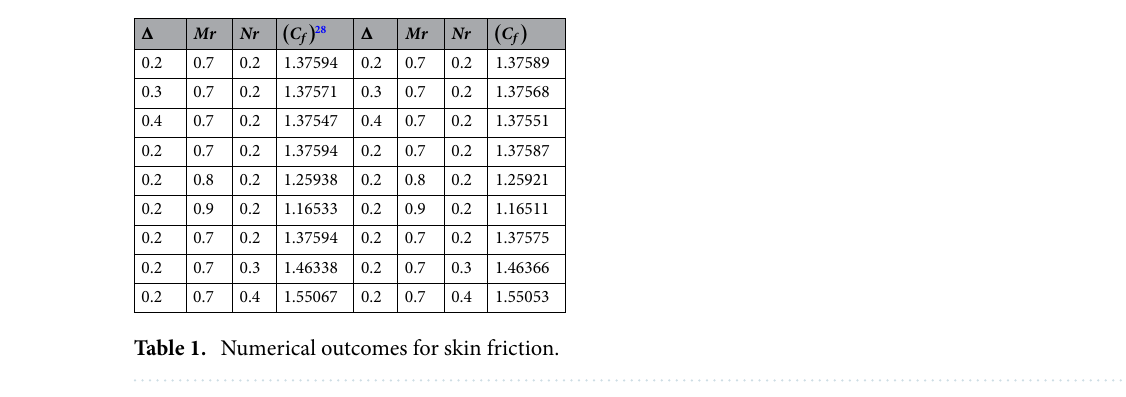
Figure 5. ( a – d ) The effects of parameters Sc , Sr and Du on dimensional less concentration profile φ(η) respectively. ( d ) Comparison of solution obtained by PCM and bvp4c method.